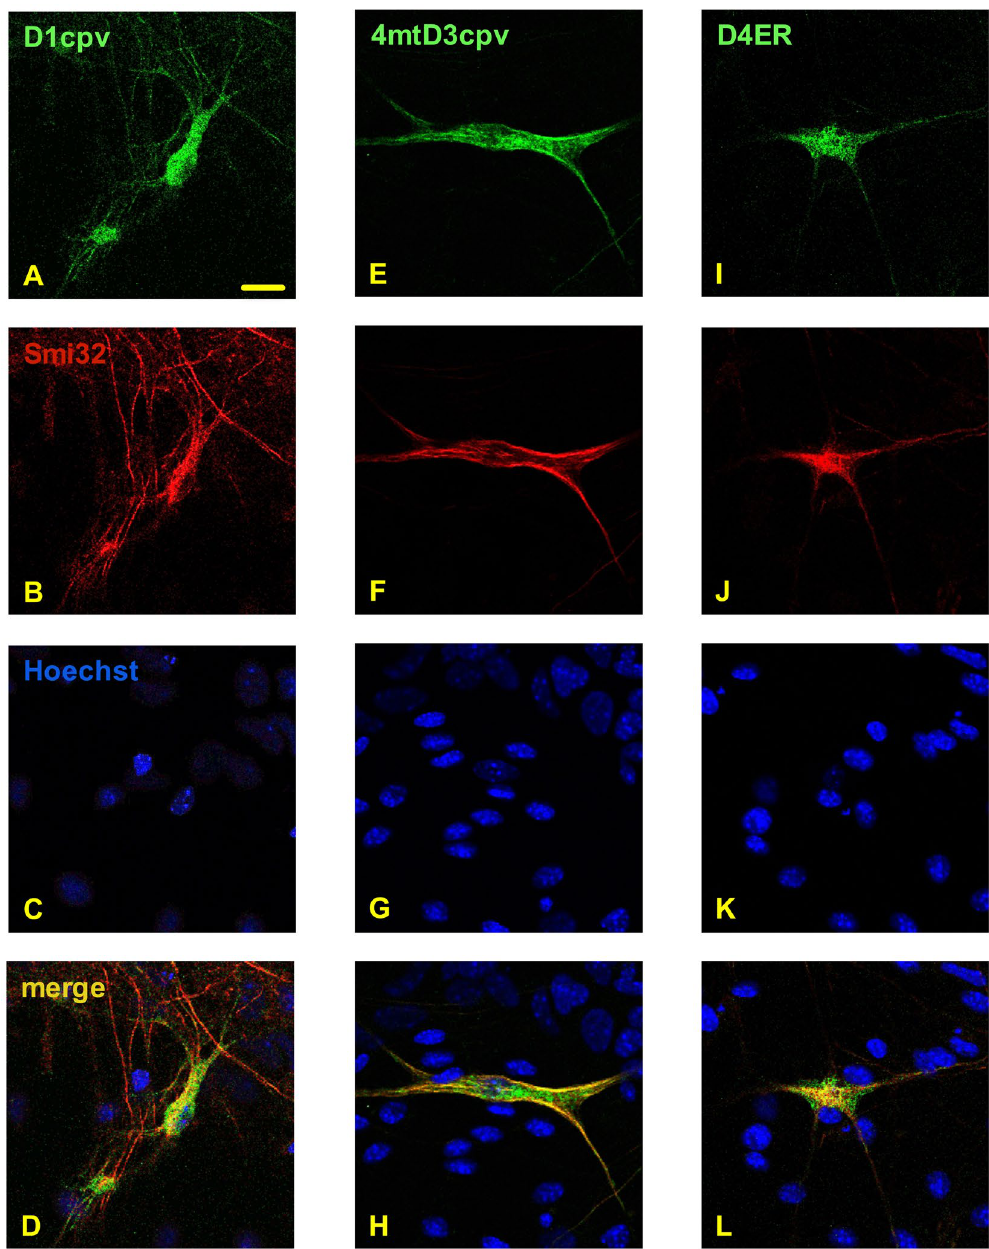
Figure 2. The cameleon probes are selectively expressed in motor neurons in mouse spinal cord primary cultures. Primary cell cultures from the mouse spinal cord were transduced with the AAV vectors coding for the cameleons targeted to the cytosol (panels A–D), the mitochondrial matrix (panels E–H) or the ER lumen (panels I–L). After 12 days of culturing, cells were fixed, permeabilised, immunostained with an antibody to the motor neuron (MN) marker SMI32, and then counter-stained with the nuclear fluoro-probe Hoechst 33342. Confocal microscope images of cells were then collected after excitation at either λ = 488 nm for visualising the fluorescent Ca 2 + probes (green signal, panels A,E,I), λ = 543 nm for visualising SMI32-positive cells (red signal, panels B,F,J), or λ = 405 nm for visualising the nuclei of all cells (blue signal, panels C,G,K). Merging of the three fluorescent channels (panels D,H,L) shows that only SMI32-positive MNs express the Ca 2 + probes (see also Supplementary Fig. S3). Scale bar = 20 µ